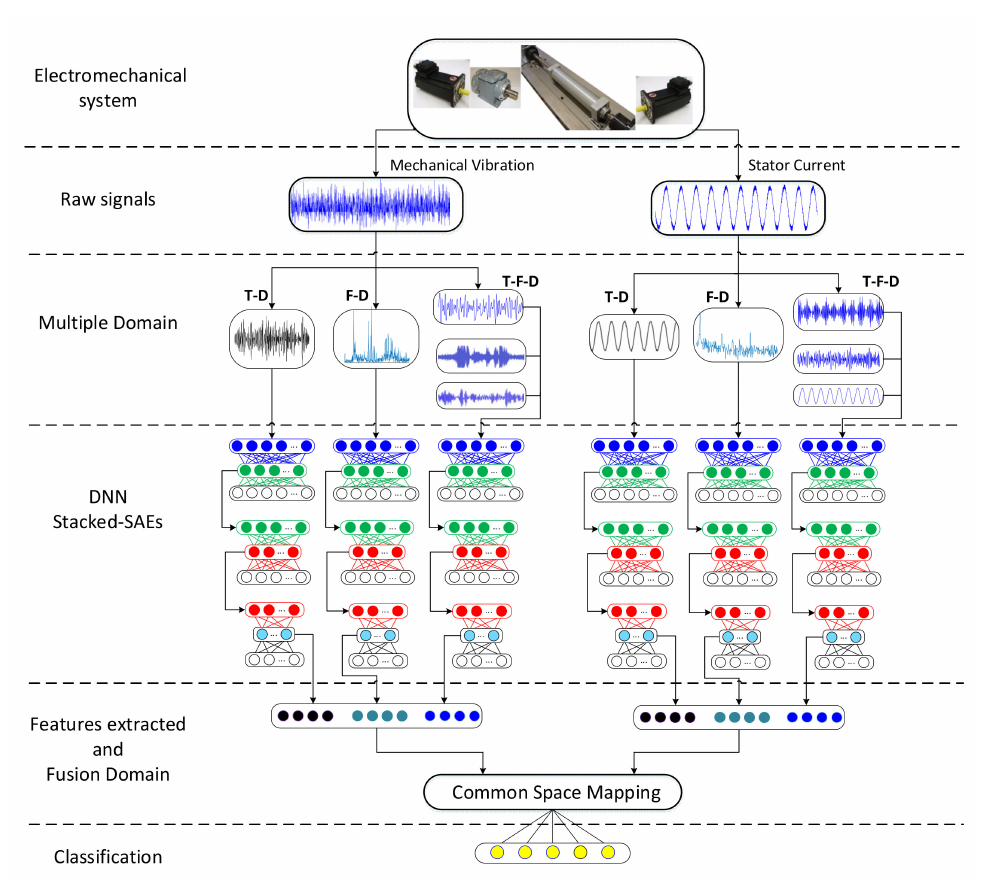
Figure 2. Procedure of the proposed diagnosis methodology based on hybrid feature extraction through multiple stacked-auto-encoders (SAEs) for the detection of multiple faults in electromechanical